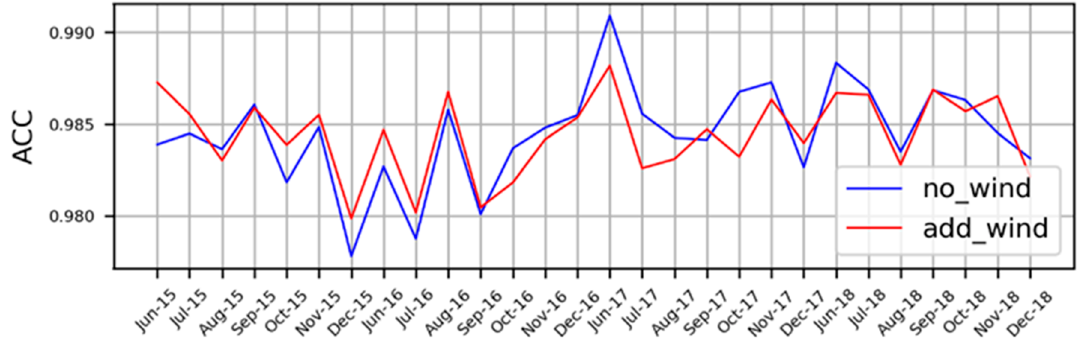
Figure 3. The ACC line chart for each month from 2015 to 2018.The blue line is ACC of convLSTM model without wind and the red line is ACC of convLSTM model with wind field data.